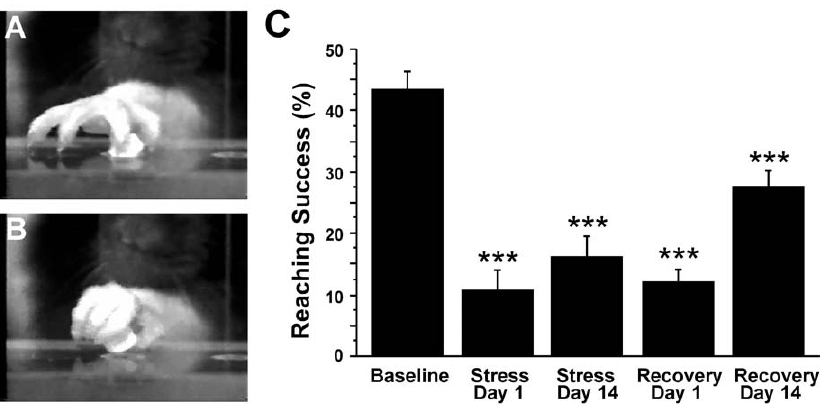
Figure 3. Skilled reaching performance in male rats. A, B: Series of photographs illustrating forelimb and digit movements of a rat grasping a food pellet. C: skilled reaching success in rats before (baseline), during and after two weeks of stress (mean 6 SEM). Note that stress diminished skilled reaching performance after acute (day 1) and chronic (day 14) of daily stress treatment. Reaching success did not return to baseline levels within 14 days of recovery. Asterisks represent statistical significance (*** p , 0.001).